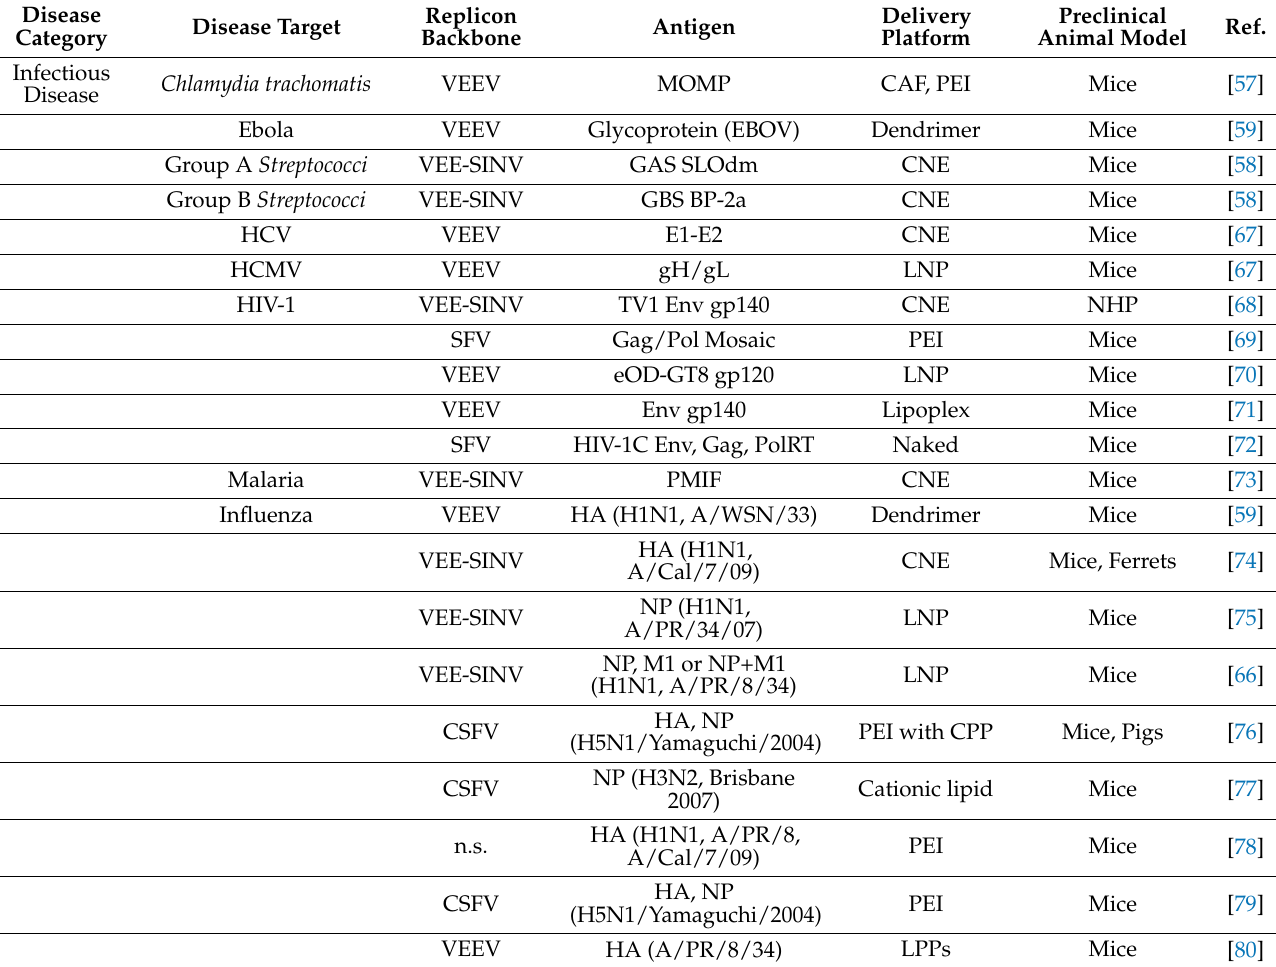
Table 2. Preclinical testing of saRNA vaccines against infectious diseases and cancer since 2015. Disease Disease Target Category Infectious